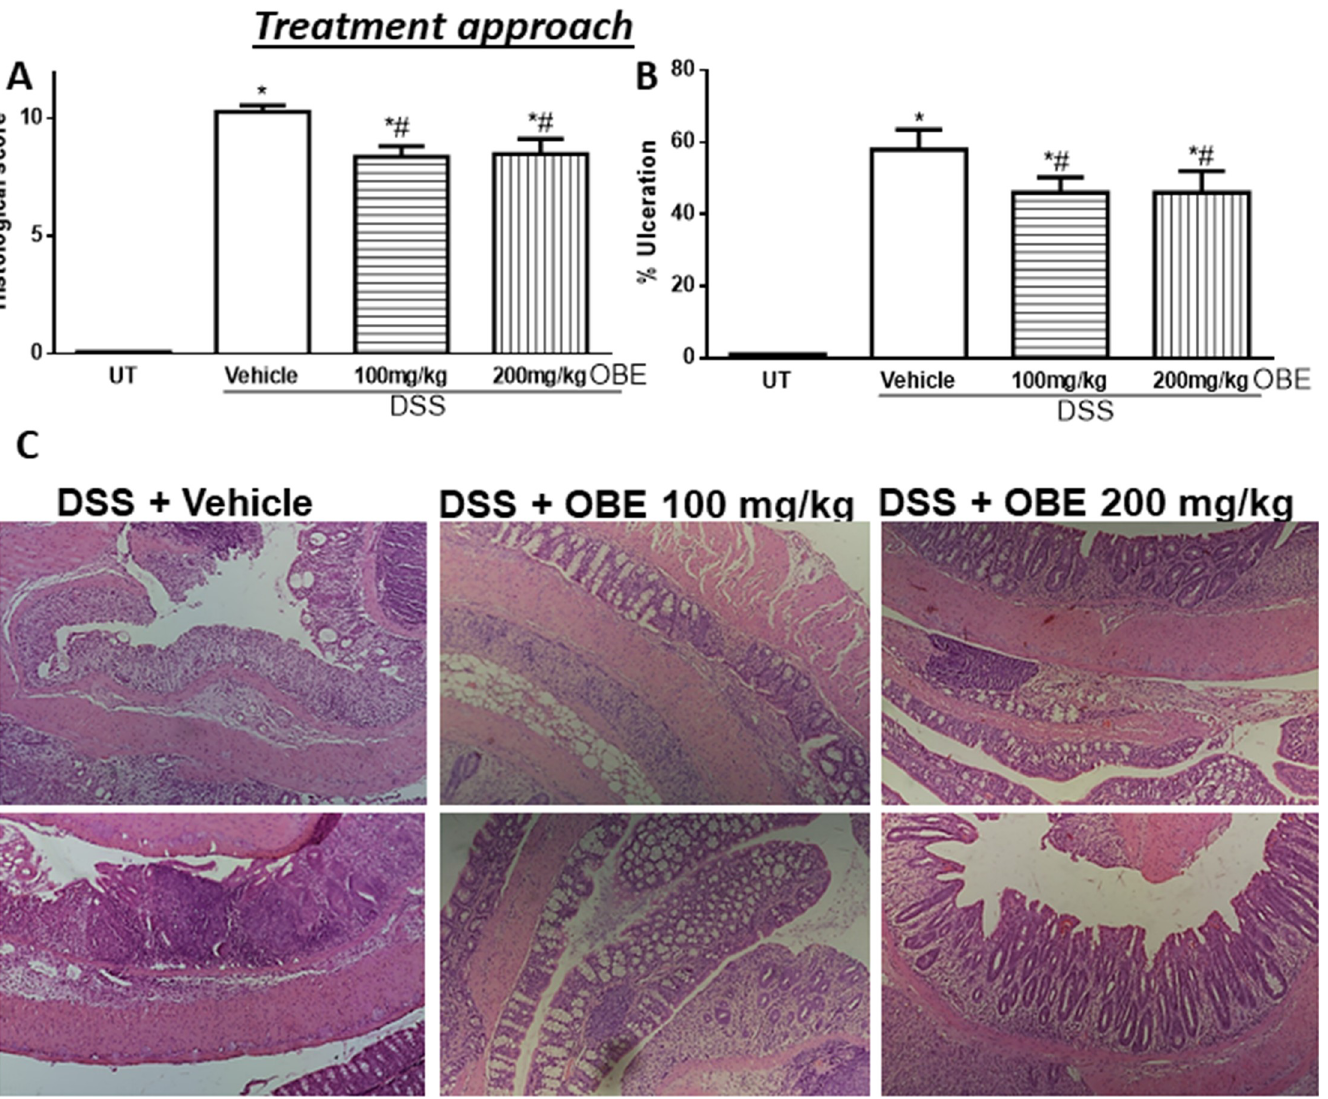
Fig 2. Effect of OBE on colitis severity at the histological level using the treatment approach. The histological assessment of colitis severity (panel A), and the % of ulceration in the whole colon section (panel B) were determined in mice receiving DSS and either various doses of OBE (hatched bars) or vehicle (solid bars), and in the UT healthy mice (open bars). Histobars represent means ± SEM for the following number of mice in each group: UT (n = 10), DSS/vehicle (PBS) (n = 16), DSS/OBE 100 mg/kg (n = 20), and DSS/OBE 200 mg/kg (n = 12). Asterisks denote significant difference from UT mice with p < 0.05 ( � ), # denotes significant difference from DSS/ vehicle-treated mice with p < 0.05. Panel C (left side) is an illustration of a colon section taken from mouse treated with DSS/vehicle where there is significant mucosal destruction, submucosal edema formation, increase muscle thickness, and significant immune cells recruitment. The middle and left sides are illustrations of typical colon sections taken from mice treated with 100–200 mg/kg doses of OBE. There was a slight improvement in the mucosal integrity and slight reduction in immune cells recruitment (10x